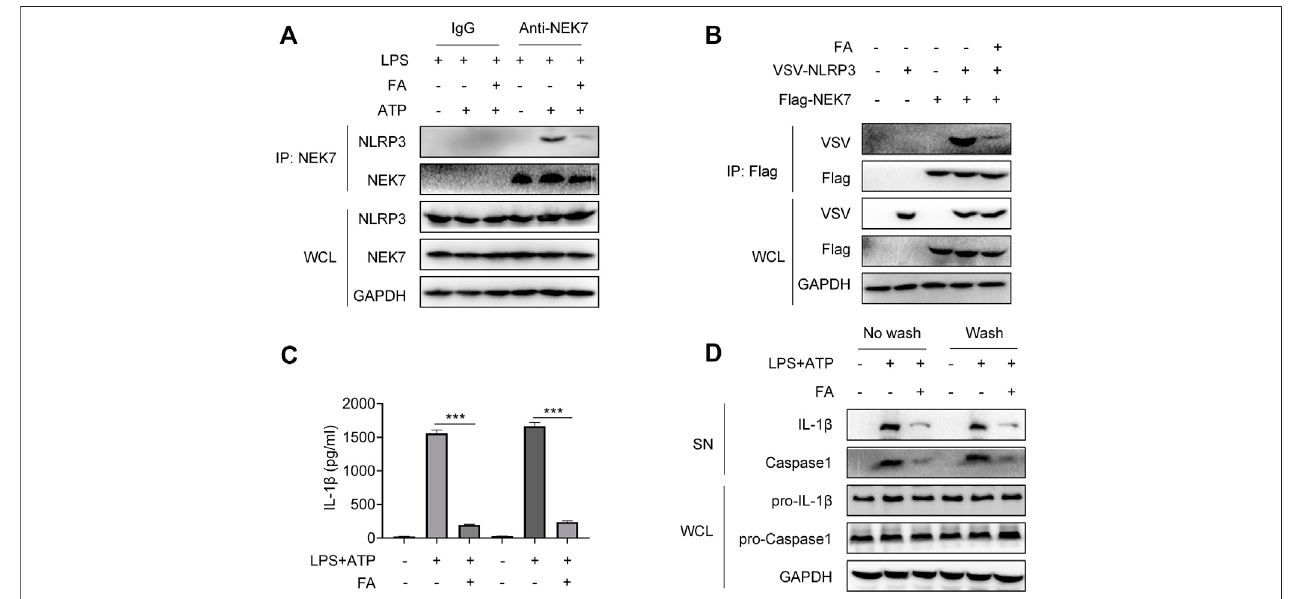
FIGURE 10 | FA inhibits NLRP3 in fl ammasome activation by interfering with NLRP3 and NEK7. LPS-primed BMDMs were treated with various concentrations of FA (20 μ M) for 15 min and then stimulated with ATP for 30 min. (A) Endogenous immunoprecipitation (IP) with NEK7 antibody or IgG in LPS-primed BMDMs stimulated withATPinthe presence orabsenceofFA(20 μ M). (B) IPand western blotanalysisofNEK7-NLRP3interactioninHEK-293Tcellstreated withFA (20 μ M).LPS-primed BMDMs were treated with FA (20 μ M) for 15 min, washed three times, and then stimulated with ATP for 30 min. ELISA analysis of IL-1 β in supernatants in each group in the presence or absence of FA (20 μ M) (C) , and western blot analysis of cleaved IL-1 β and caspase-1 (p20) in SN, and pro-IL-1 β and pro-caspase-1 in the whole-cell lyses (WCL) (D) . Data are expressed as the means ± sd from three independent experiments or are representative of three independent experiments. ** p <